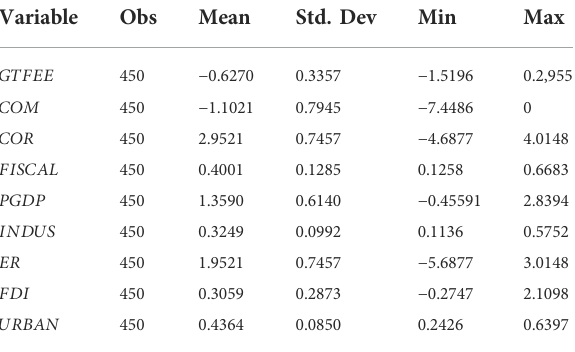
TABLE 1 Variables description.